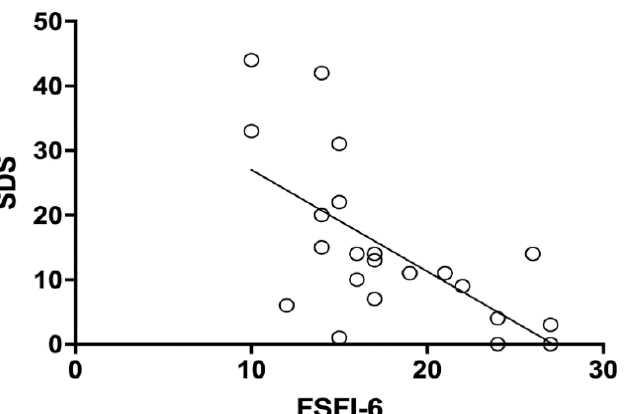
Figure 3. Correlation between FSFI-6 total scores and sexual distress in adrenal insufficiency group (Pearson correlation test; p = 0.001; r-0.65). (Pearson correlation test; p = 0.001;